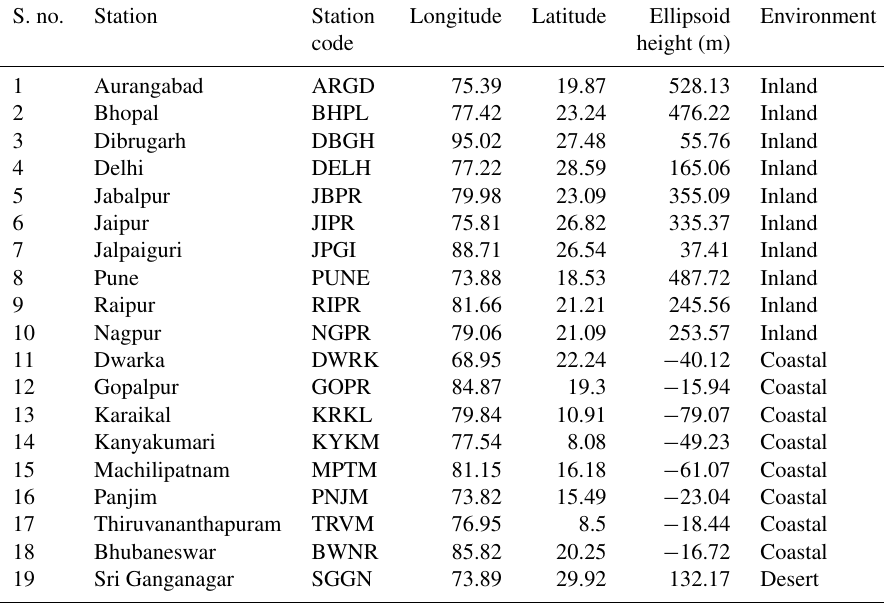
Table 2. List of GNSS stations (latitude, longitude, height) and location environment. S.